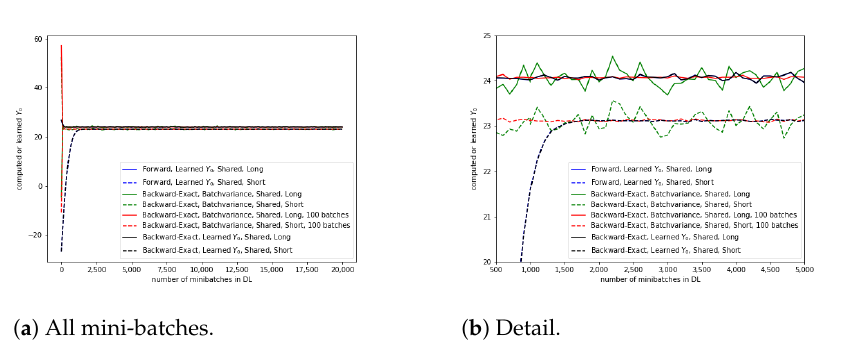
Figure 5. Y 0 estimates or parameters for the straddle case—all 20,000 mini-batches ( a ) and detail ( b ). Exact backward step. (Batch size 256). The results for Taylor backward step look very similar.